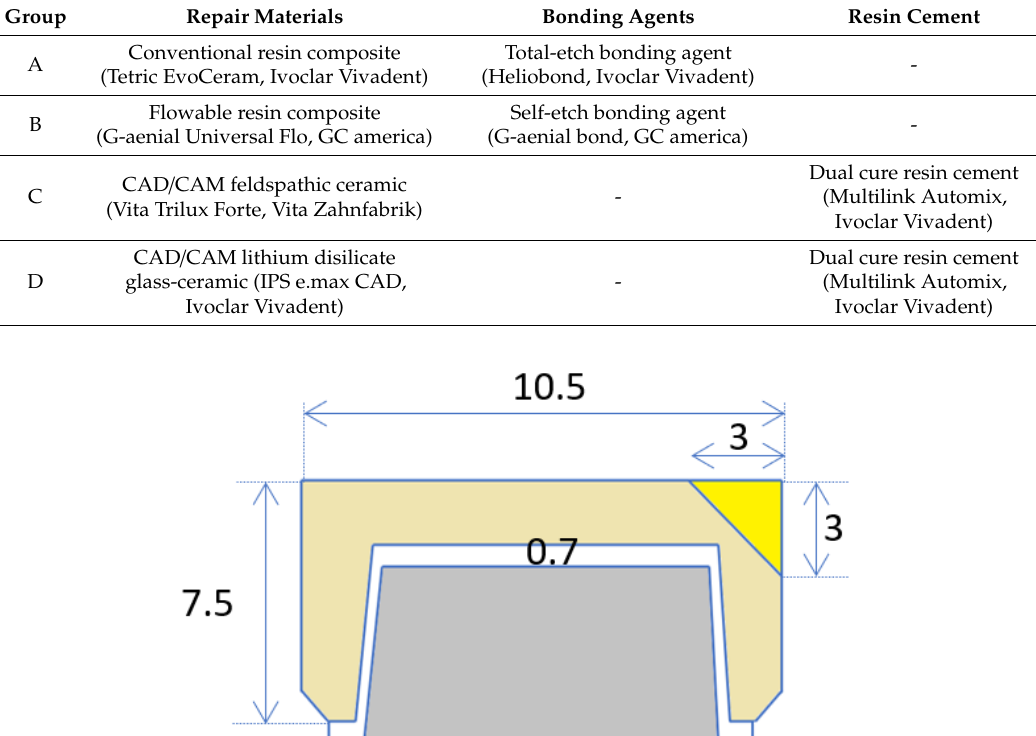
Table 1. Experimental groups and materials used in this study.